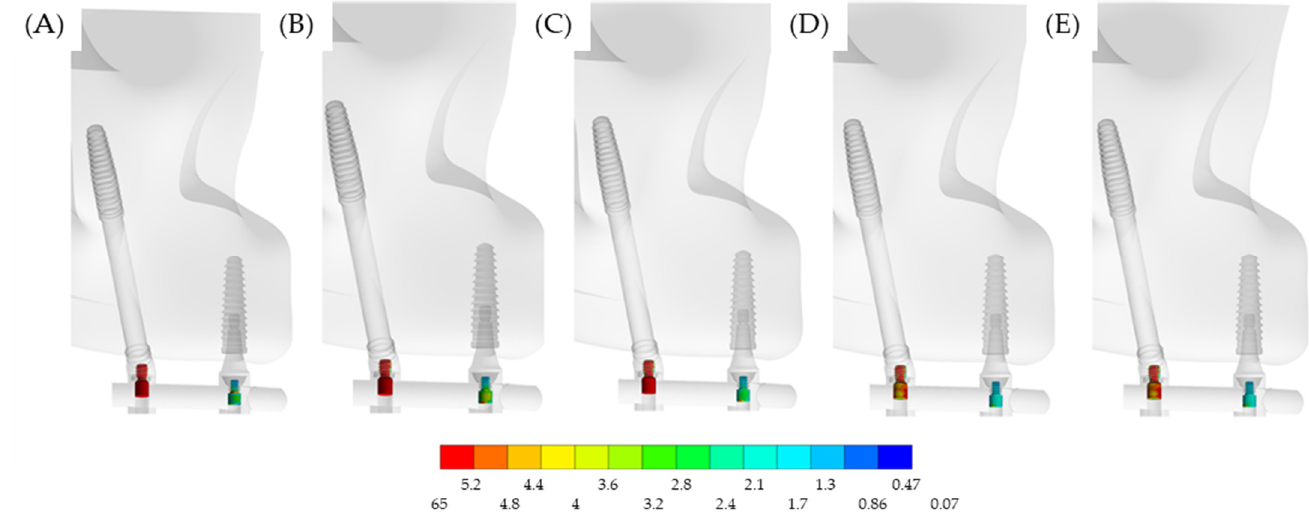
Figure 8. Lateral view of the von-Mises stress distribution in the prosthetic screws according to the different superstructure materials: ( A ) PEEK, ( B ) CF, ( C ) Ti, ( D ) CoCr and ( E ) Zi. Both posterior and anterior prosthetic screws were involved in the load distribution, with a greater effect at the posterior one. Regardless, when the elastic modulus of the superstructure material decreases, the stress concentration on the screw increases.